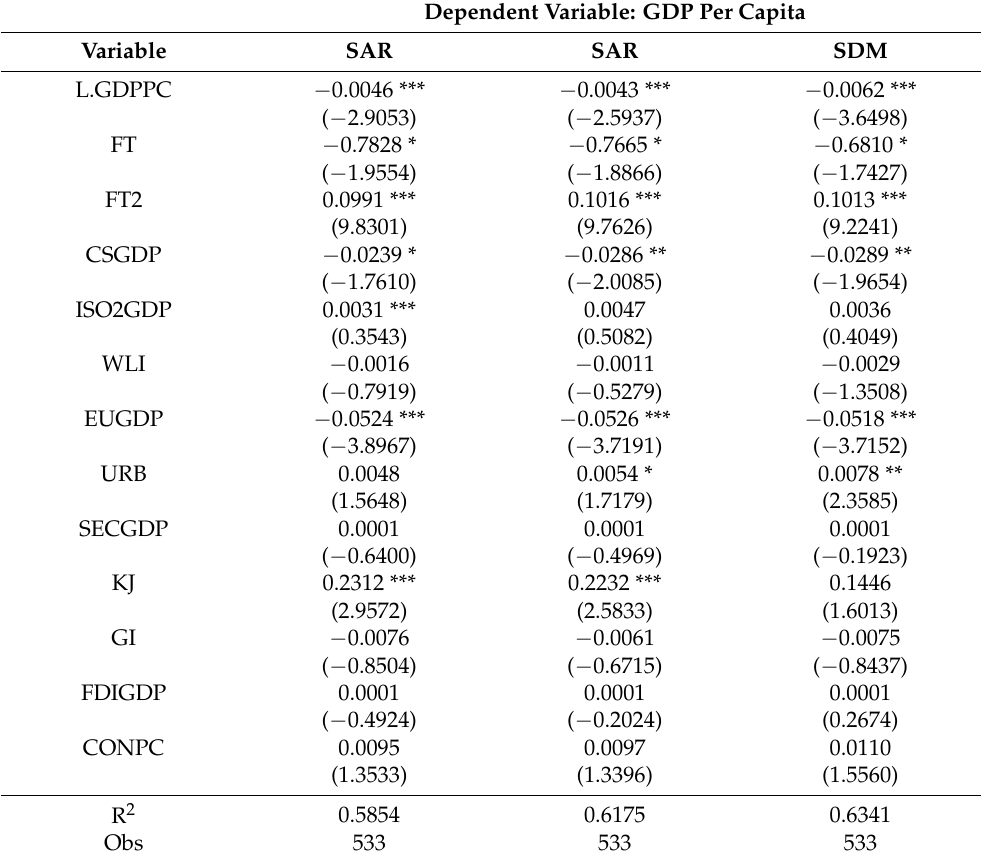
Table 7. Results of robustness